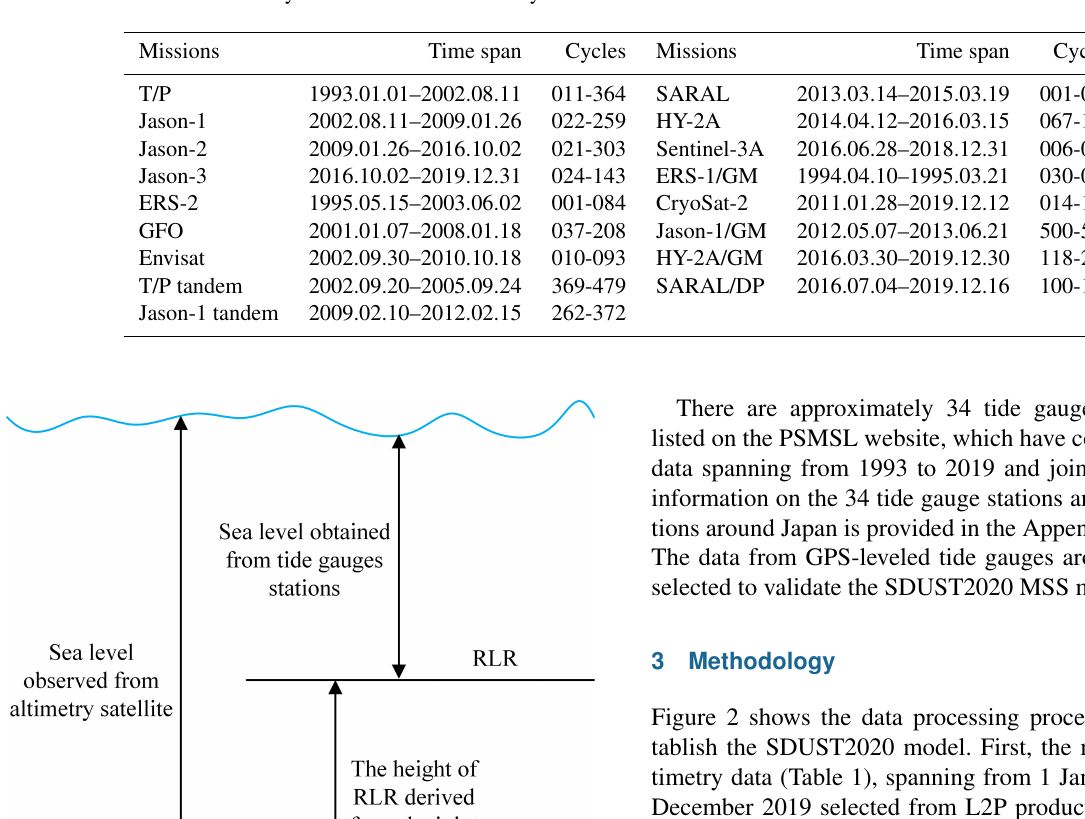
Table 1. Multi-satellite altimetry data was used in this study.